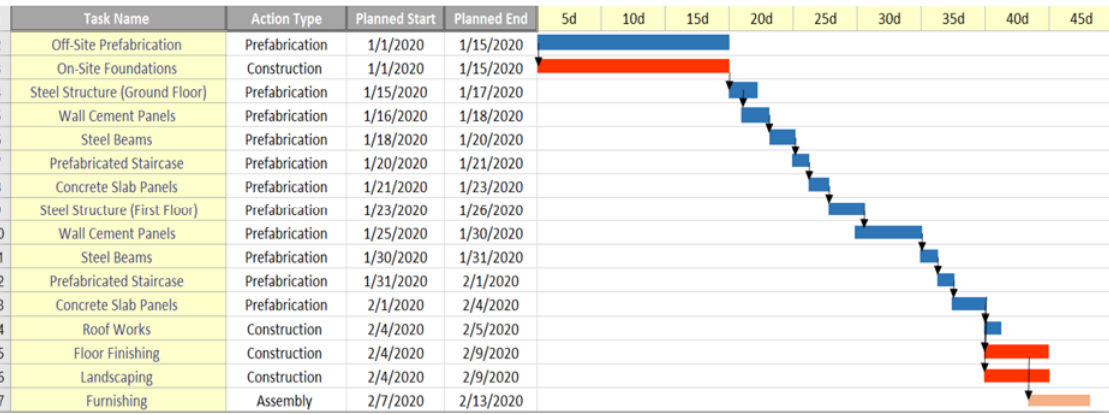
Figure 6. Simulating construction timeline with BIM from foundation to completion.